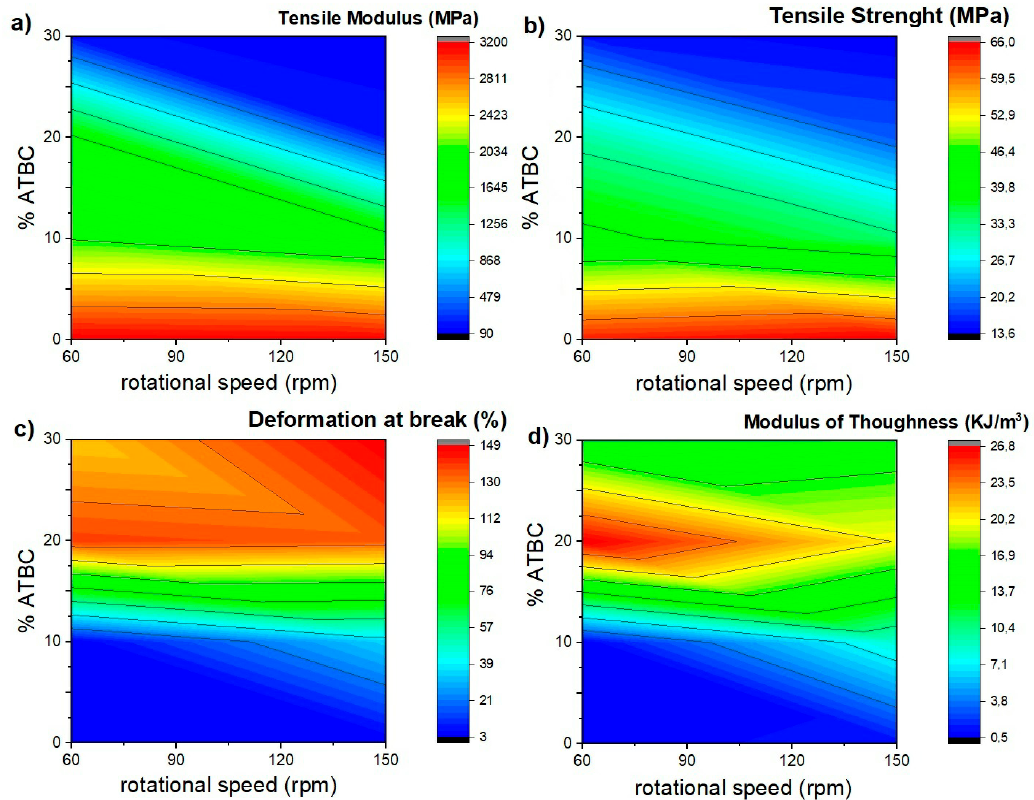
Figure 10. Two-dimensional contour of neat PLA and PLA-ATBC tensile properties: ( a ) Tensile Modulus, ( b ) Tensile Strength, ( c ) Deformation at Break, ( d ) Modulus of Toughness.